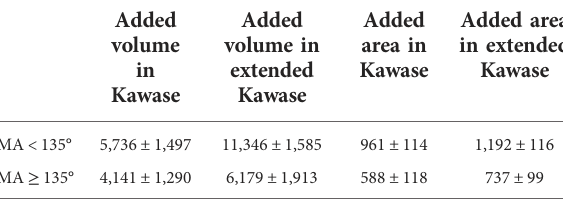
TABLE 2 Added volume and area in Kawase and extended Kawase approaches (mm 3 /mm 2 ).